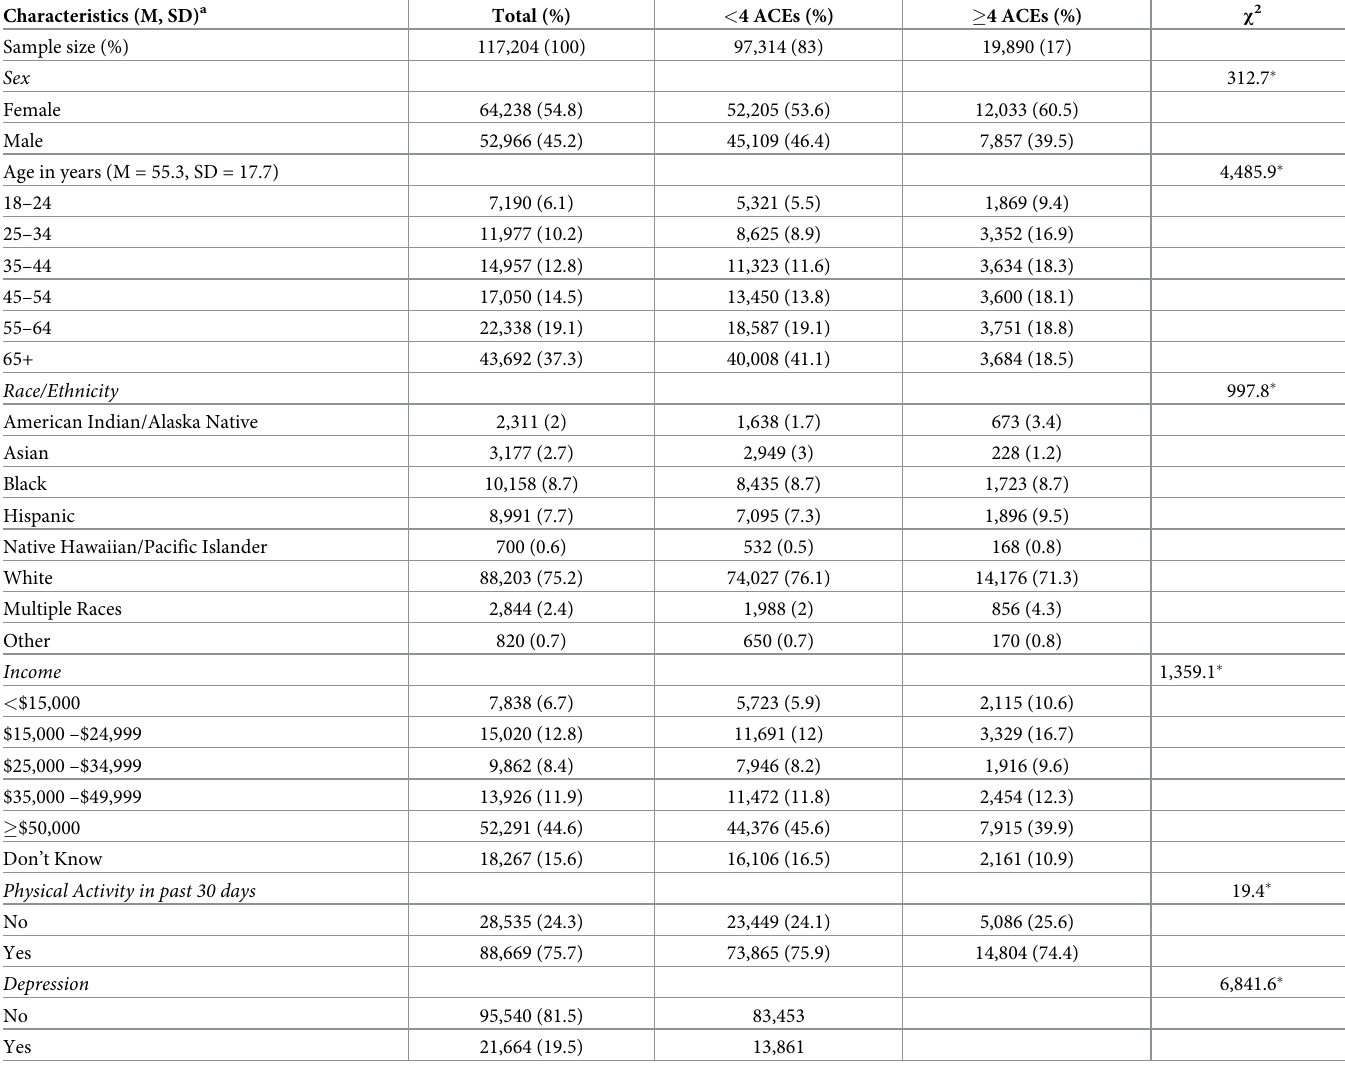
Table 1. Participant characteristics and Descriptives by Adverse Childhood Experiences (ACEs) among U.S. Adults (n = 117,204). Characteristics (M, SD)